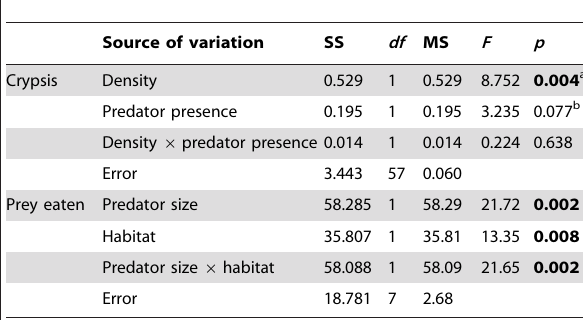
Table 2. ANCOVAs for crypsis and the number of prey eaten.